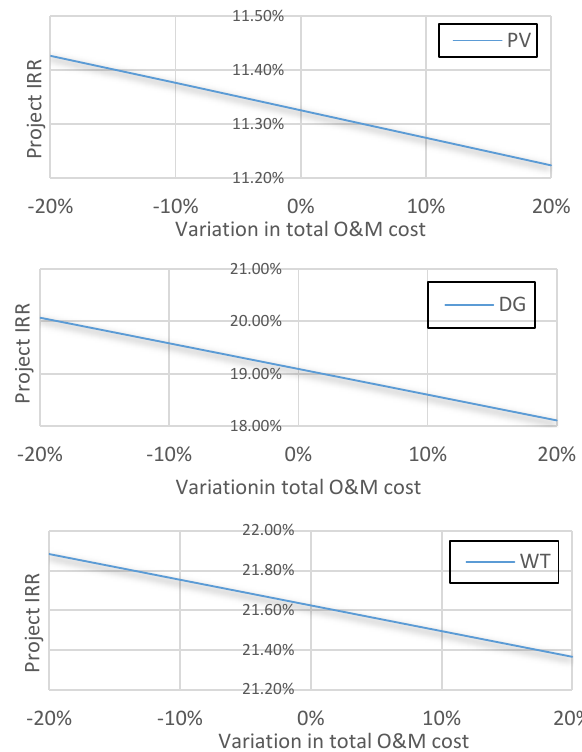
Figure 7. Sensitivity analysis of operation and maintenance (O&M) cost variation e ff ect on project IRR.